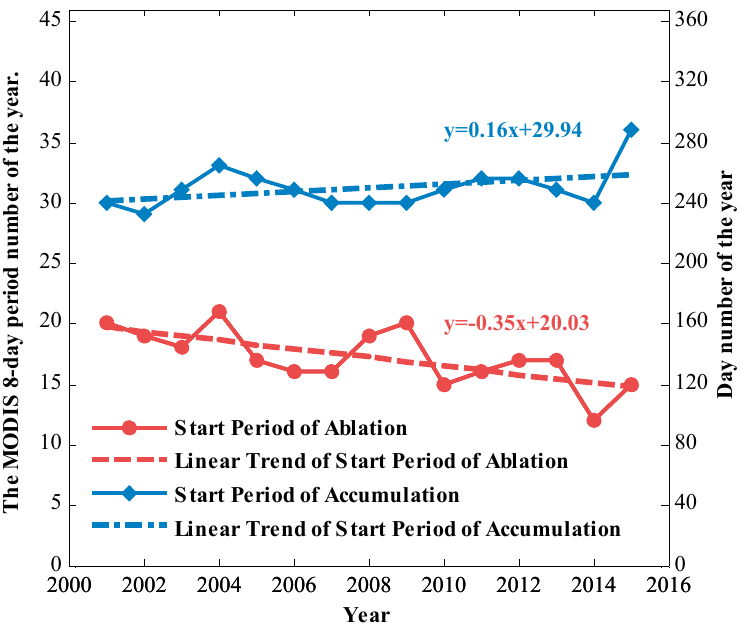
Figure 7. The starting periods of snow accumulation and ablation.